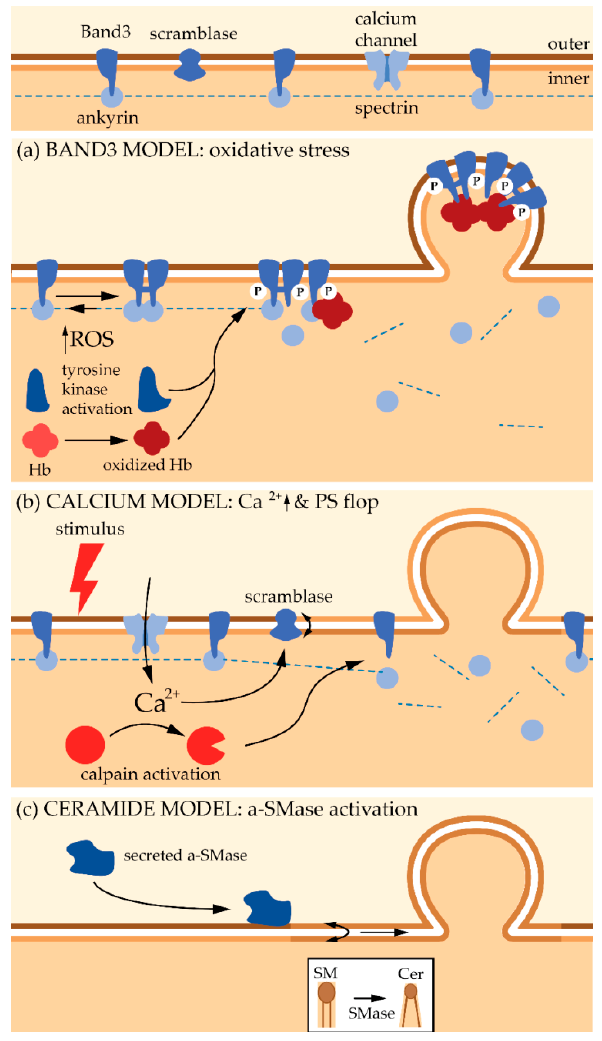
Figure 4. Models described in the literature for the biogenesis and shedding of red blood cell-derived microvesicles. Hb: haemoglobin; P: phosphorylation; a-SMase: acid